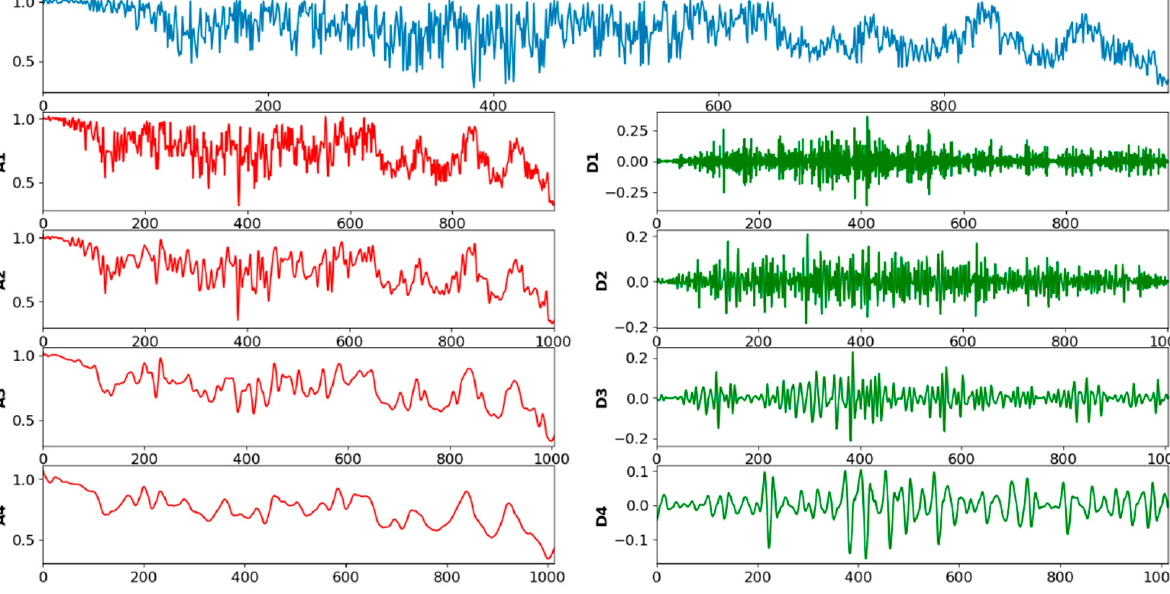
Figure 7. Signal reconstruction for a sample dataset with the wavelet method.